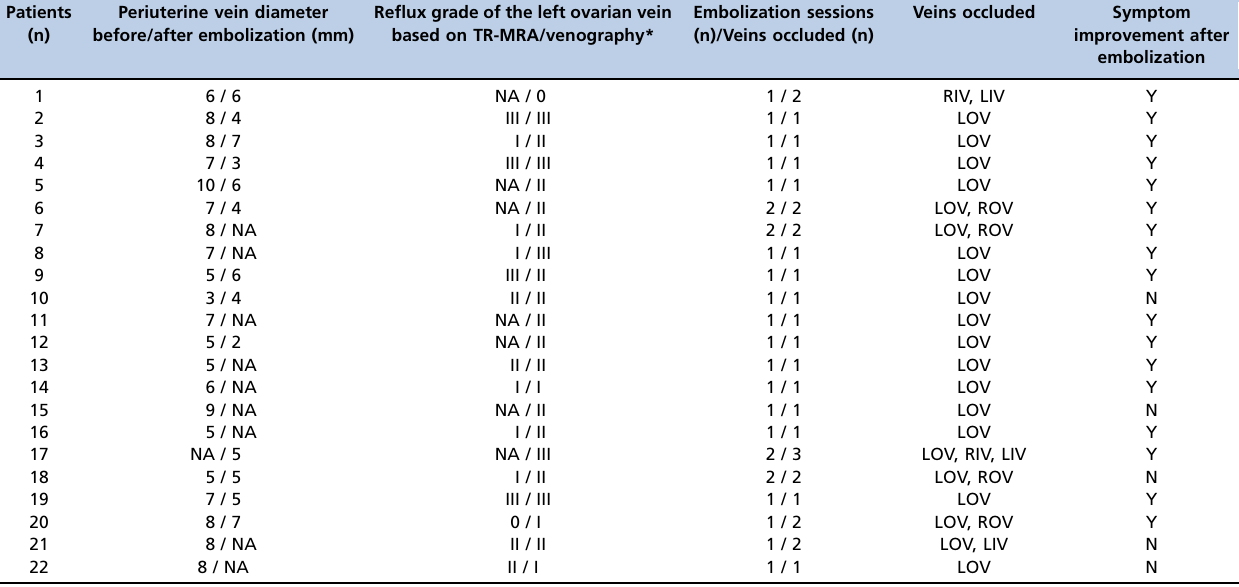
Table 3 - Patient radiological and procedural data. Patients Periuterine vein diameter (n) before/after embolization (mm)